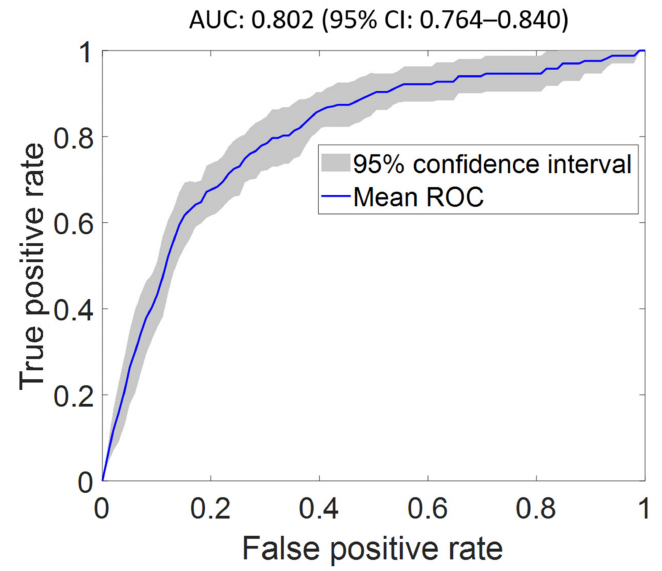
Figure 4. Optimal receiver operating characteristic curve of pulmonary embolism classifier using the optimal feature set (FS2) as input. The proposed model achieved an AUC of 0.802 (95% CI: 0.764–0.840), which is superior to the AUC of the classifier using all features (FS1) as